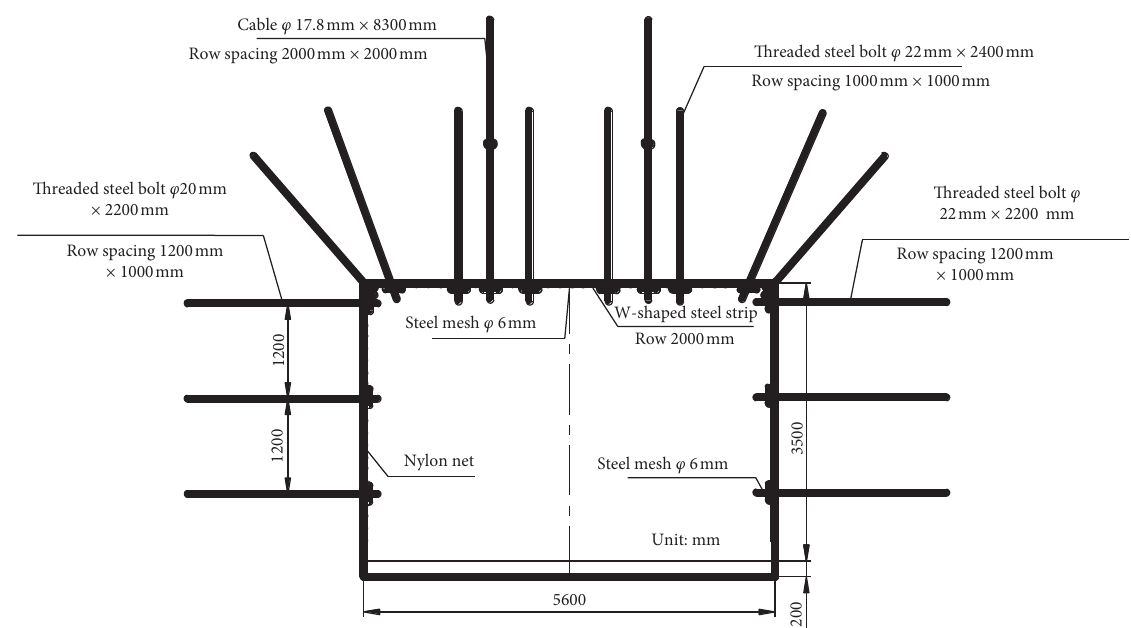
Figure 2: The support scheme of 2203 transportation roadway.